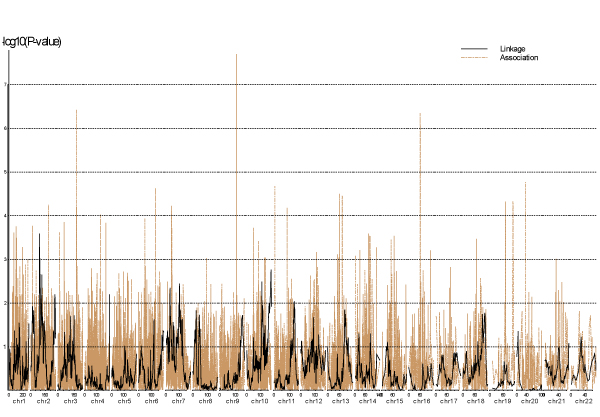
Genome-wide linkage and association scans. Negative of logarithm (base 10) for p-values from linkage (solid line) and association (dotted line) analyses using SNP markers.